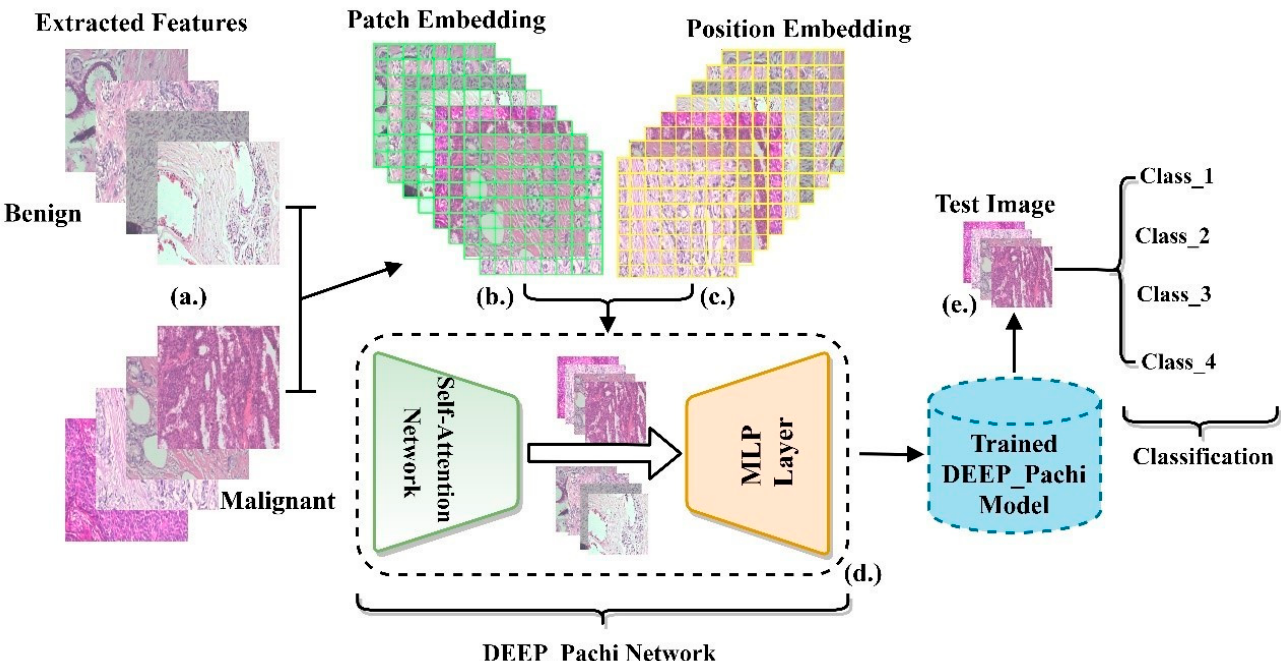
Figure 2. Proposed model block diagram. ( a ) depicts the extraction of input image features via the backbone models (ensemble model). The Deep_Pachi networks accepts the extracted features in two scenarios ( b ) Patch embedding and ( c ) Position Embedding. ( d ) depicts DEEP_Pachi framework components which are the self-attention Network and MLP Layer. ( e ) depicts the testing stage with new images on the trained DEEP_Pachi Network.